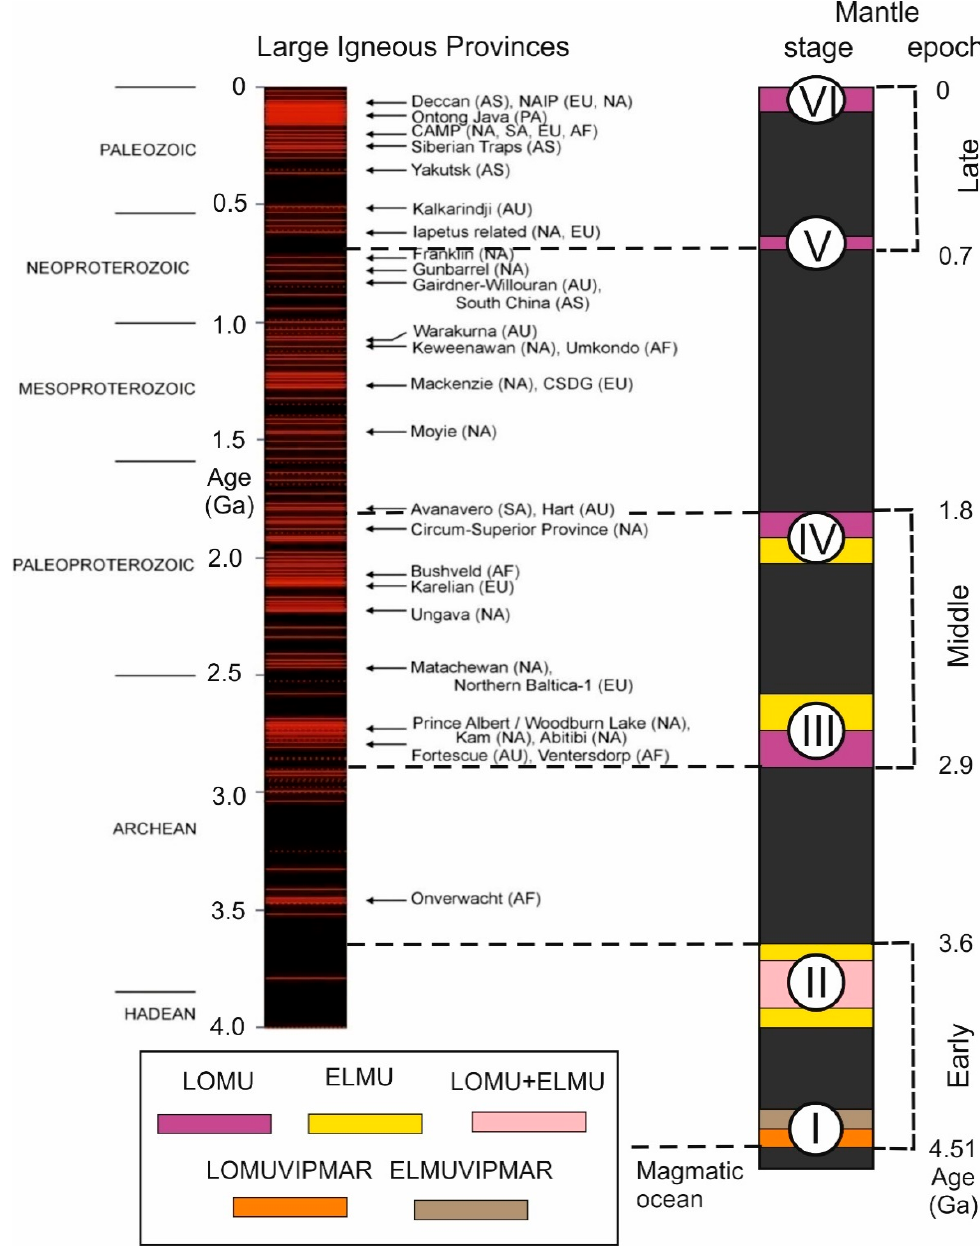
Figure 15. Comparison of the age mantle systematics, defined in sources of volcanic rocks from unstable Asia, with LIPs recorded world-wide. The LIP barcode is shown after [151].